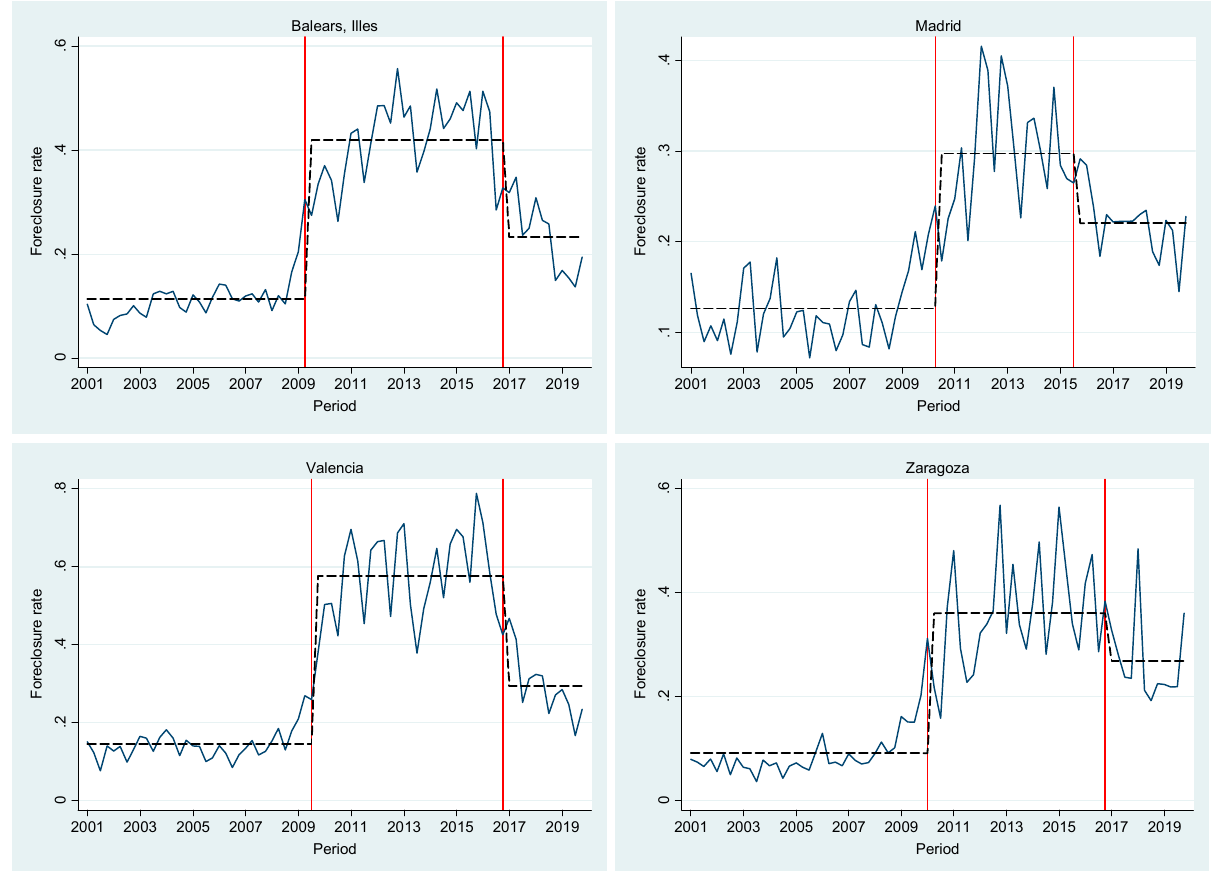
Figure 3. Foreclosure rates and their changing means (selected regions). The graphs show the foreclosure rates, along with the permanent breaks in their means (dashed lines) and the dates of a structural break (vertical lines).